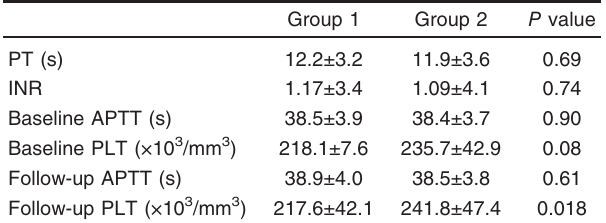
Table 2 Comparison between the two groups regarding their hemostatic profile